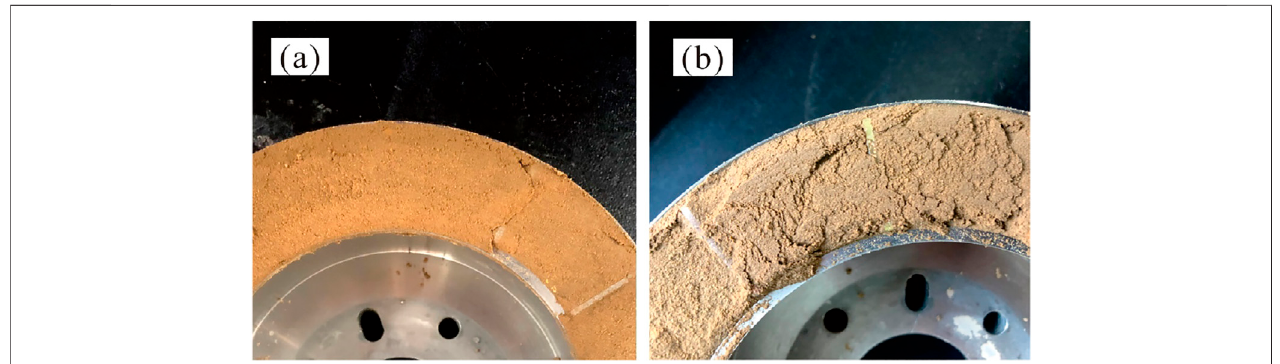
FIGURE 16 | Shear surface morphology (A) Smooth shear surface (B) Step shear zone.